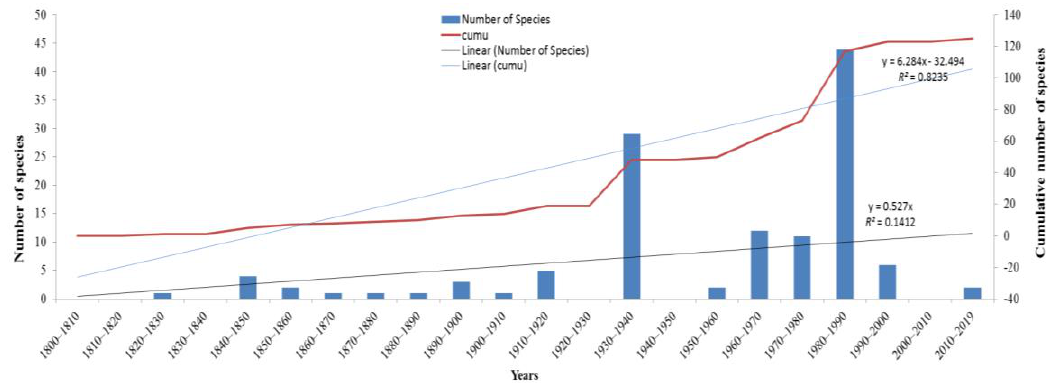
Figure 2. Decade-wise analysis related to the reporting of new taxa from Indian waters.